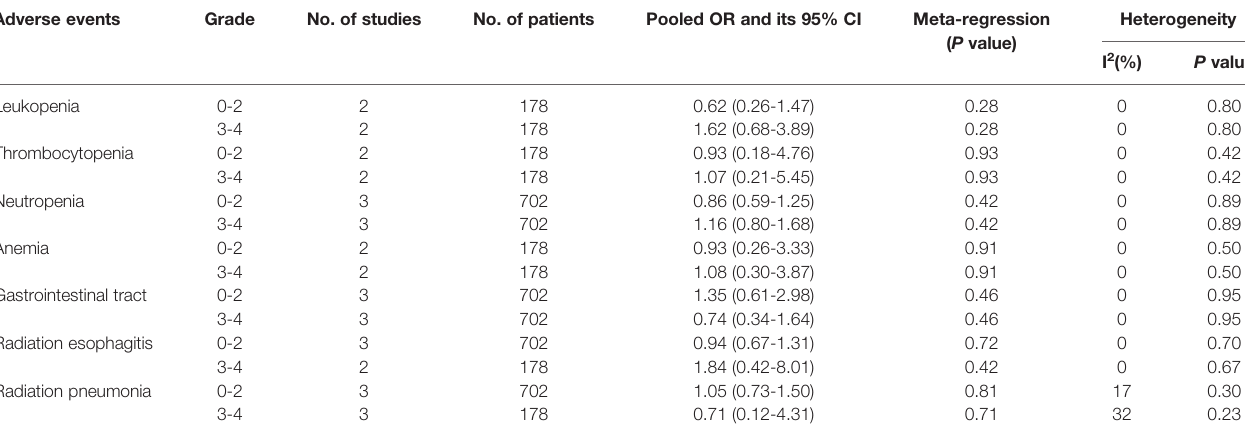
TABLE 2 | Adverse events during the CCRT-CCT or CCRT-alone period. Adverse events Grade No. of studies No. of patients Pooled OR and its 95% CI Meta-regression